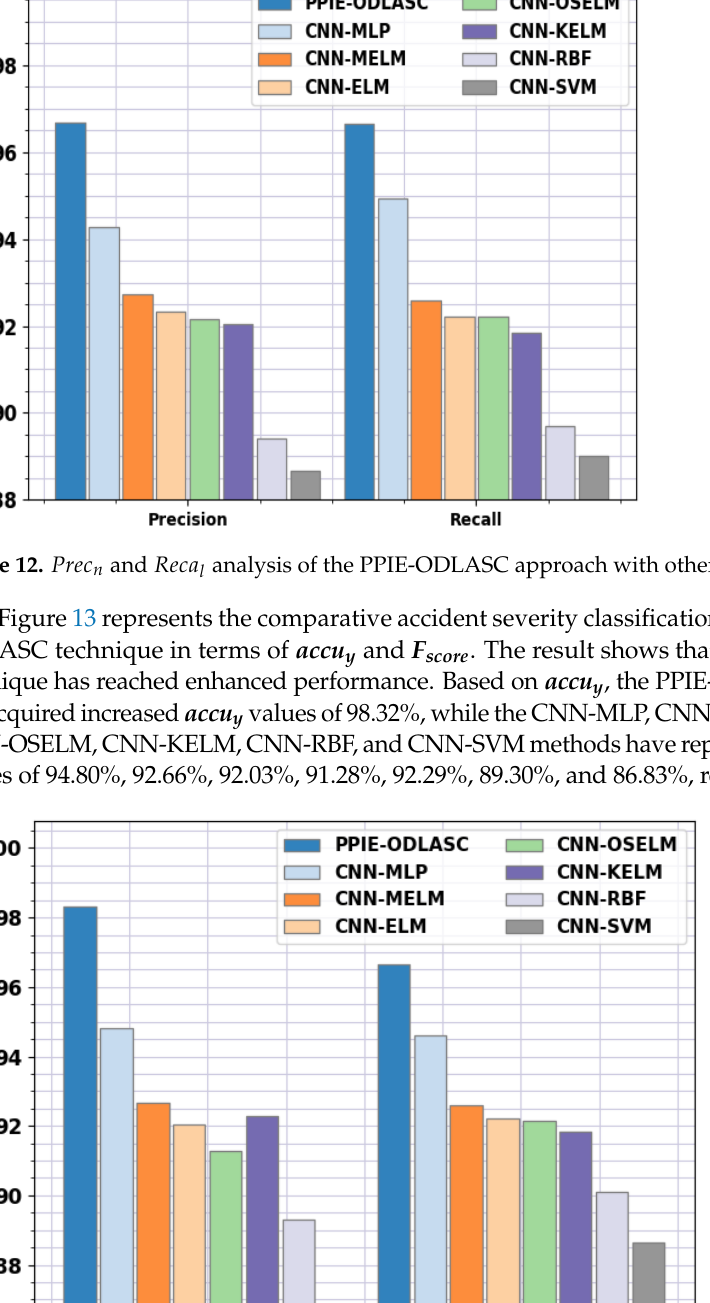
206.74 Figure 13 represents the comparative accident severity classification results of the PPIE-ODLASC technique in terms of